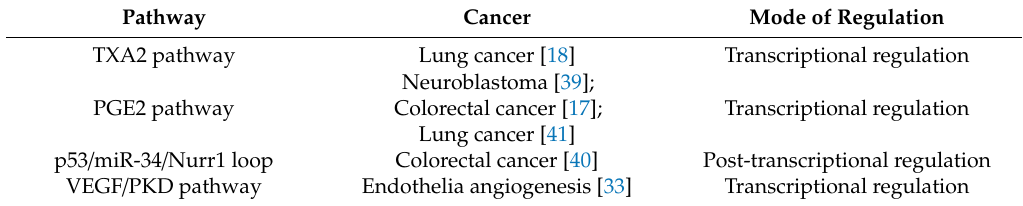
Figure 2. Schematic overview of signaling pathways regulating Nurr1 expression. TXA2, PGE2, and VEGF pathways modulate phosphorylation of NF- κ B and CREB to regulate the transcriptional activity of Nurr1. p53 / microRNA-34 / Nurr1 forms a positive feedback loop to suppress p53 activation and the subsequent expression of microRNA-34, leading to the upregulation of Nurr1 protein expression. EP: prostaglandin E 2 receptor; PGE2: prostaglandin E 2 ; TP: thromboxane A 2 receptors: TP; TXA2: thromboxane A2: VEGFR: vascular endothelial growth factor receptor; VEGF: vascular endothelial growth factor; G12 / 13: G 12 / G 13 alpha subunit; Gs: G s alpha subunit; Gq: G q alpha subunit; κ B: kappa-B; CRE: cAMP response elements; p53 RE: cAMP p53 response element. Table 2. Signaling pathways regulating Nurr1 expression in cancer development.